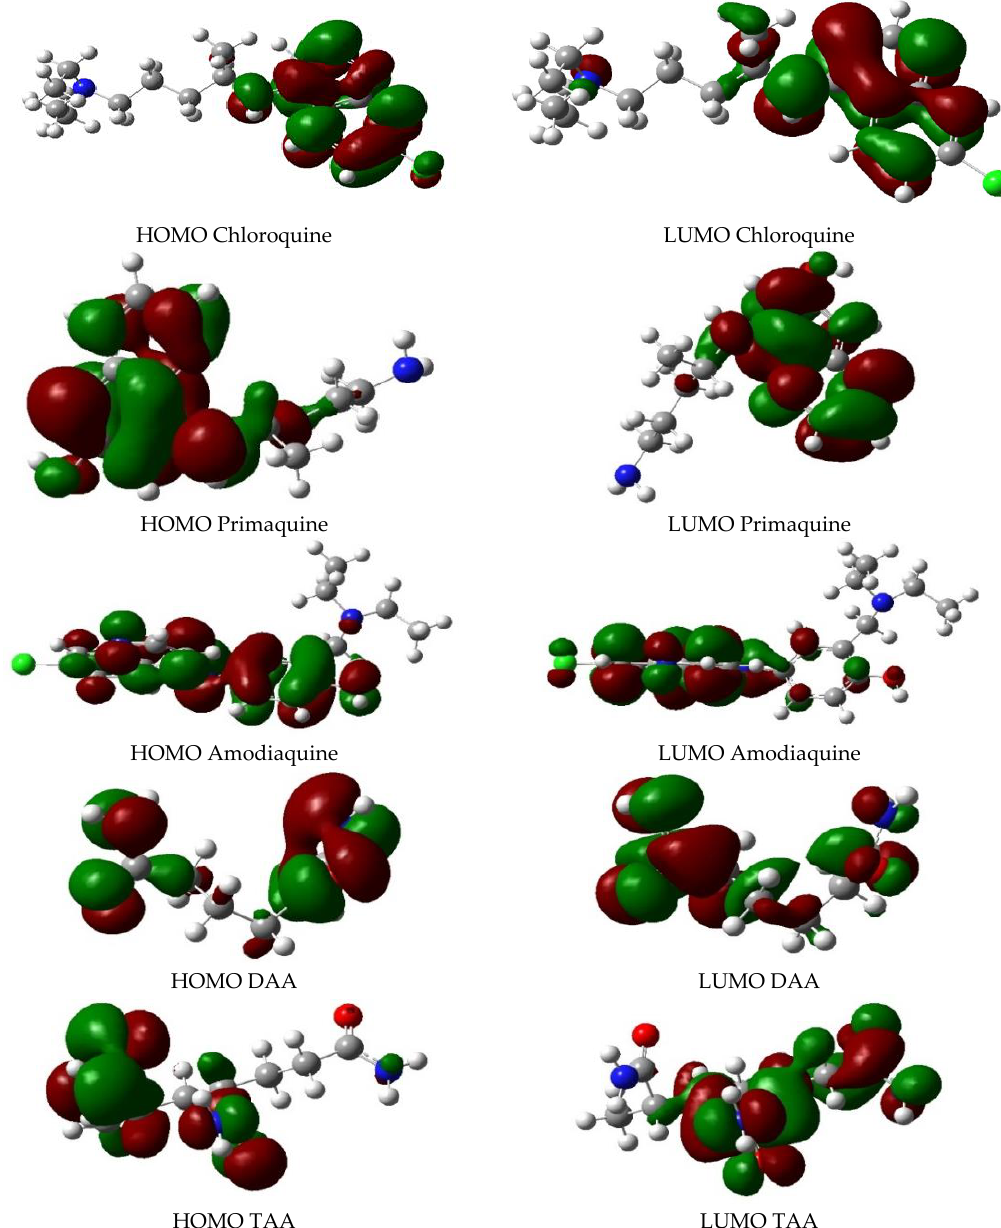
Figure 3. Frontier orbital for the all molecule studies herein. HOMO: High-occupied molecular orbital; LUMO: low unoccupied molecular orbital.